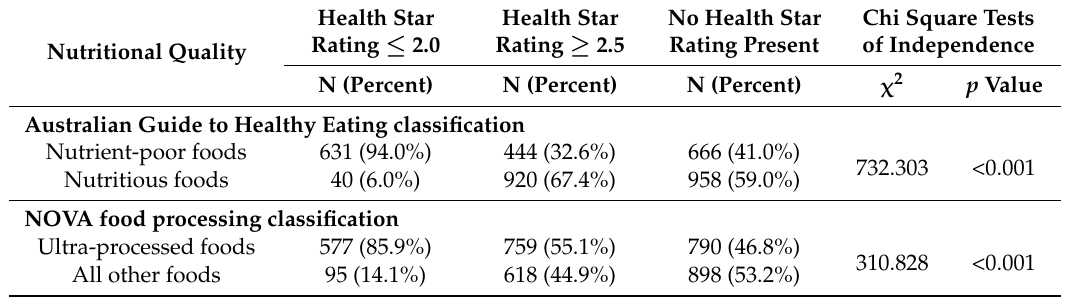
Table 5. Chi-square test of independence between HSR scores and measures of nutritional quality.